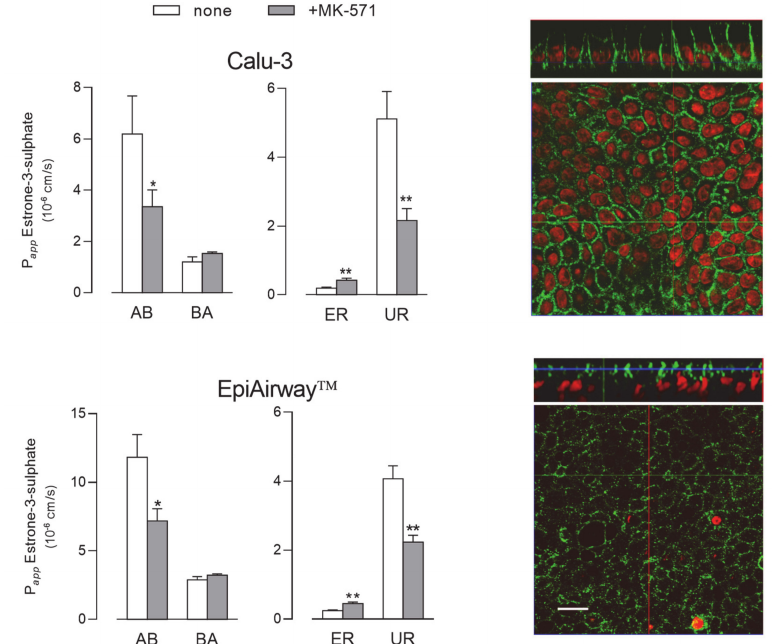
Figure 6. MRP1 activity and expression in Calu-3 cells and EpiArway ™ cultured under ALI conditions for 21 d. Left: the apical-to-basolateral (AB) and basolateral-to-apical (BA) fluxes of 3 H-estrone-3-sulphate (0.5 µ M, 3 µ Ci / mL) were monitored both in the absence (none) and in the presence of 50 µ M MK-571, as indicated. Data obtained were employed to calculate the e ffl ux (ER) and uptake (UR) ratio, as defined in Methods. Bars represent the mean ± SEM of three independent experiments. * p < 0.05, ** p < 0.01 vs. none. Right: the expression of the transporter was evaluated by means of confocal laser scanning microscopy. Green signal: MRP1 immunolabeling; red signal: nuclear staining with propidium iodide. A single XY scan is shown, along with the XZ section of the plane (top). Scale bar = 10 µ